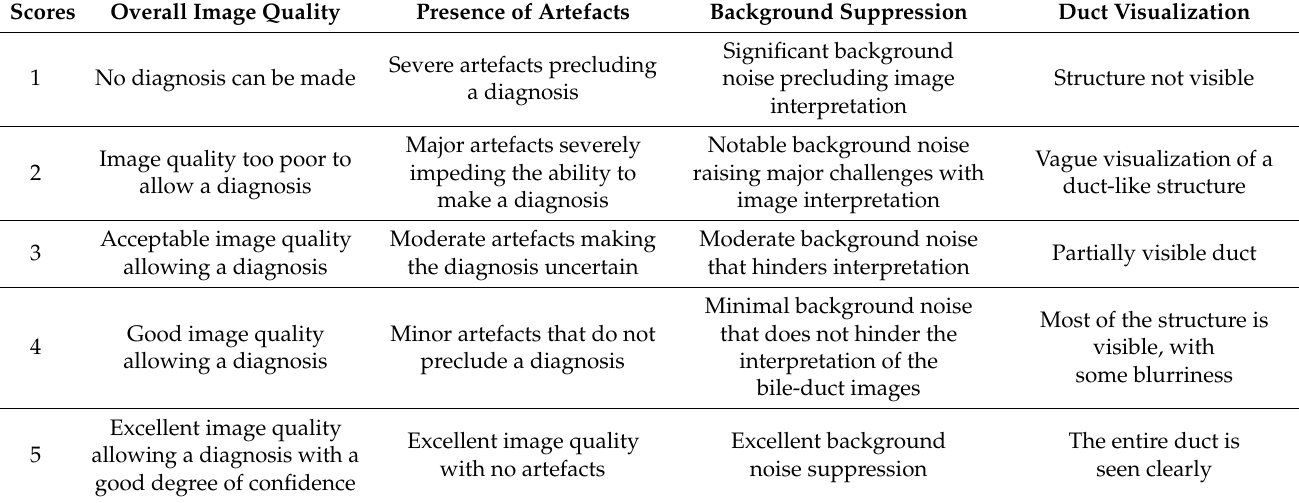
Table 2. Likert scale used to evaluate the qualitative image-quality: overall image quality, presence of artefacts, background suppression, and bile-duct